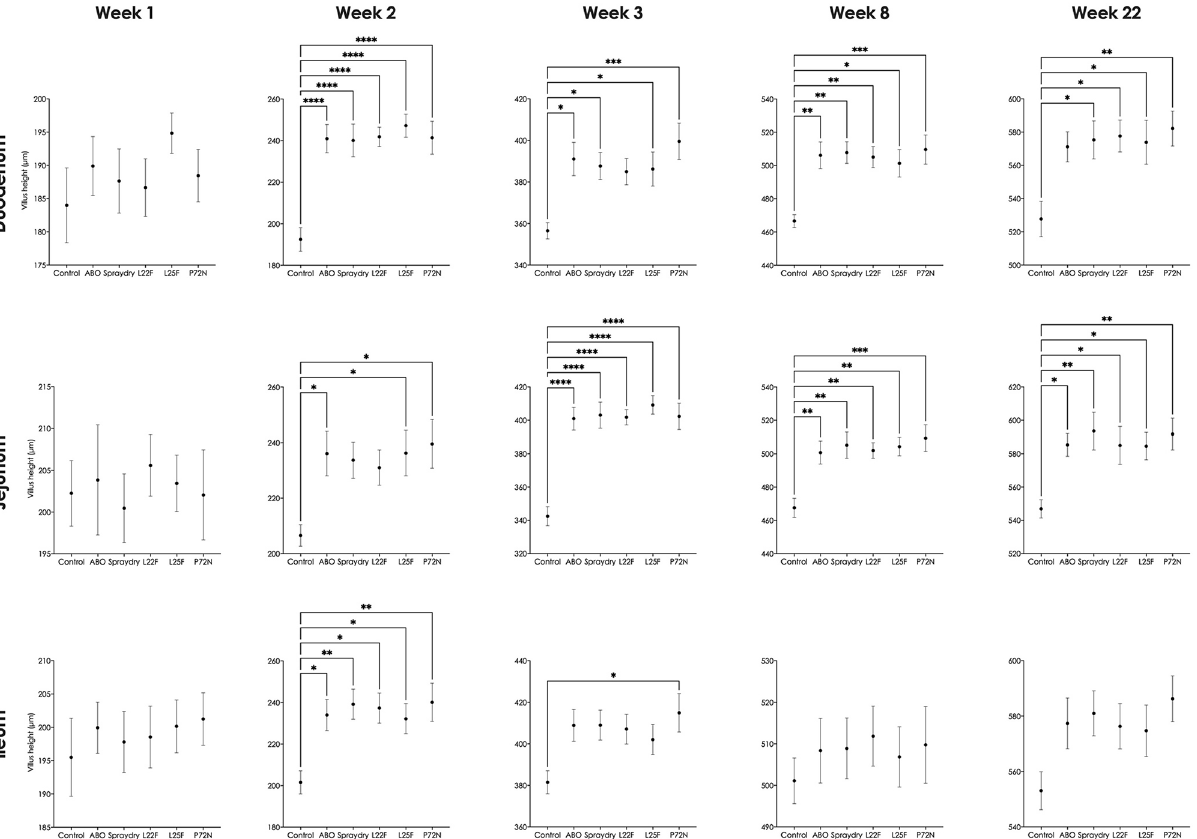
Figure 2. The villus height (duodenum, jejunum and ileum) of pigs in each group over the experimental period. The asterisks represent statistically significant differences (* P < 0.05, ** P < 0.01, *** P < 0.001 and **** P <